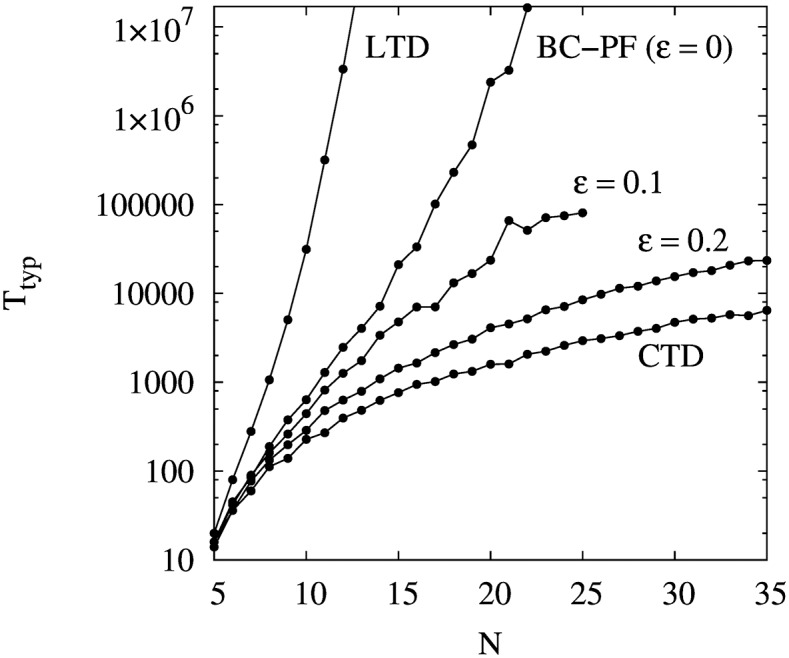
Typical (median) number of iterations Ttyp -in time steps- to converge to a balanced configuration as a function of the number N of agents in the system for p = 0.1.The upper and lower curves correspond to the pure Antal (LTD) and the Constrained Triad Dynamics (CTD) models, respectively. The other three curves correspond to the BC-PF dynamics with ε = 0, ε = 0.1 and ε = 0.2, respectively. Each point represents the median value of 1000 different runs departing from random initial conditions with equal proportion of positive and negative links.